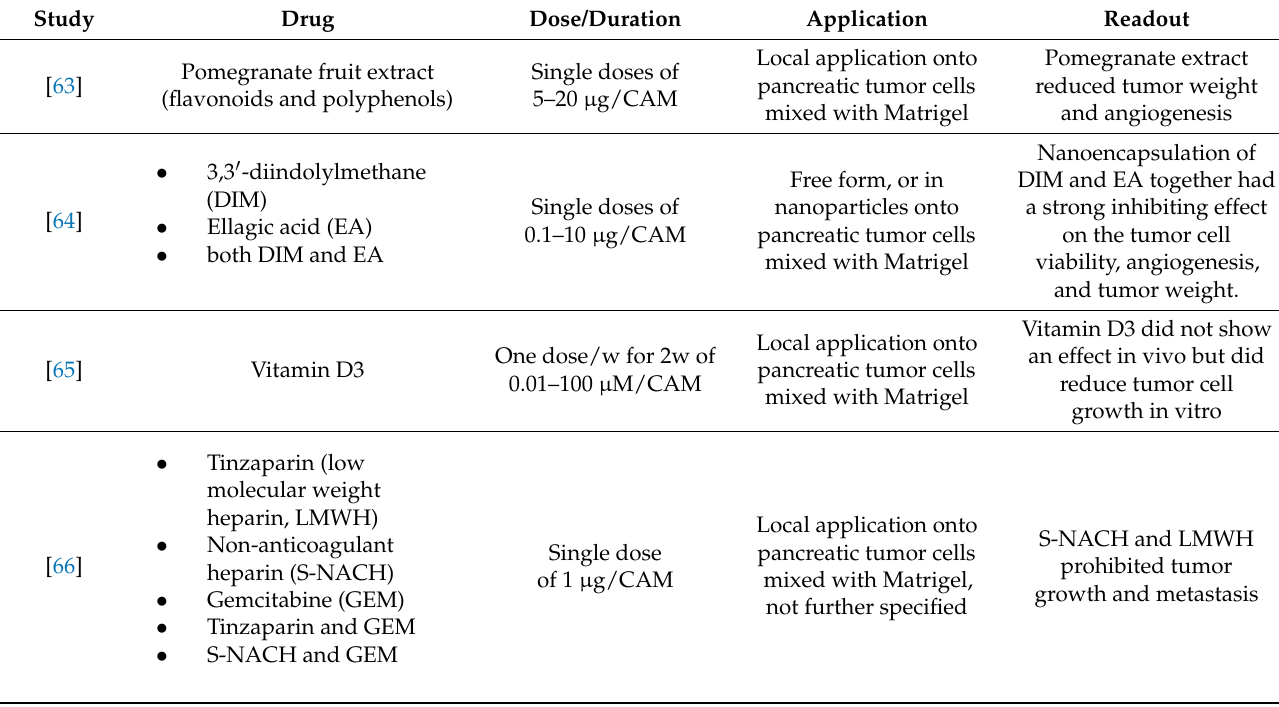
Table 3. Overview of the aforementioned drug protocols that involved the CAM model as a drug testing platform for the assessment of pancreatic